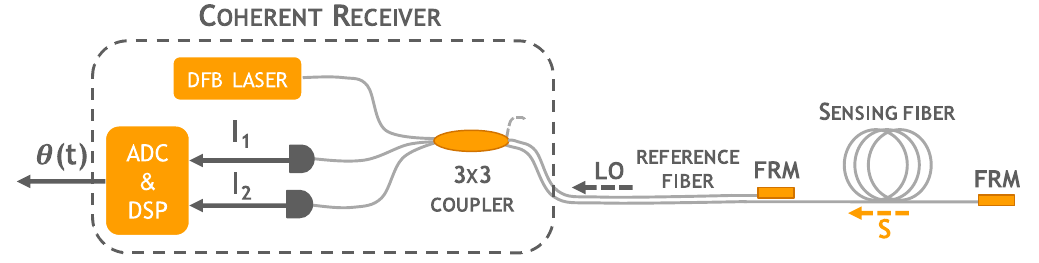
Figure 2. Phase-diversity coherent detection scheme exploiting a 3 × 3 optical coupler. The third 3 × 3 output is properly terminated to avoid light reflections.